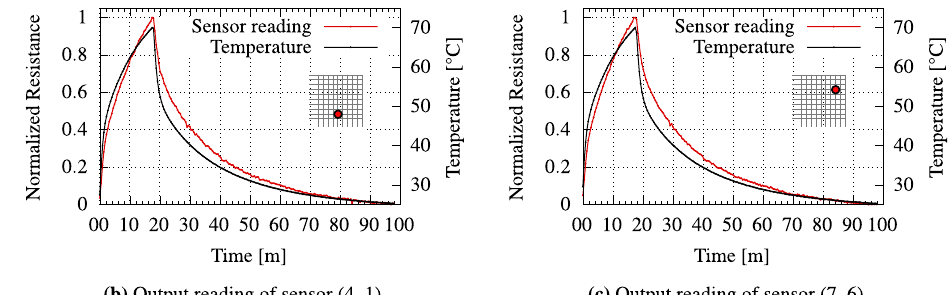
Figure 3. ( a ) The peltier-based measurement setup. ( b , c ) In a first step the peltier element is set to reach a temperature of 70 °C. After the heating phase, the peltier element is turned off, which allows the sensor array to cool down. During the heating and cooling periods, the sensor array sheet is continuously read. Two examples for the obtained sensor readings along with the corresponding temperature for two different temperature sensors within the array are presented in ( b , c ). As shown, the changes in the resistance of the PEDOT-based temperature sensor follows the changes of the